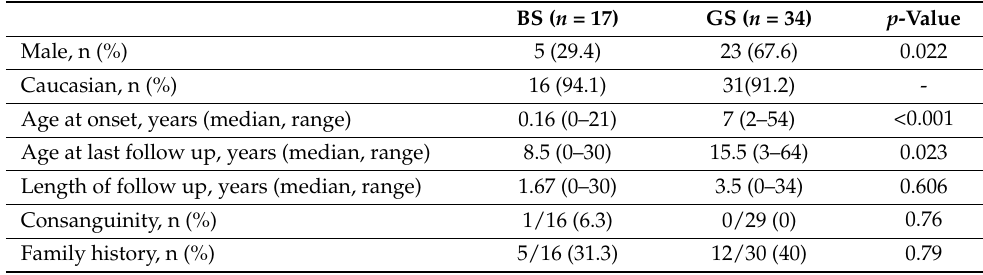
Table 2. Clinical and biochemical features of patients according to genetic